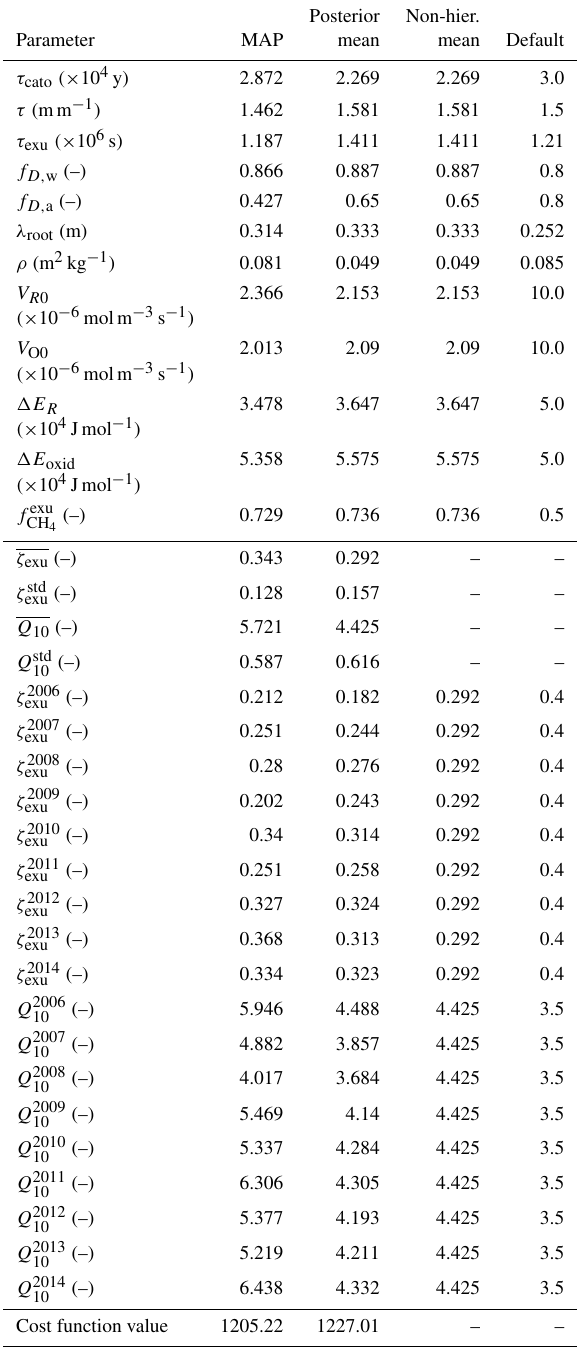
Table 4. Parameter values obtained in the optimization of the sqHIMMELI model with importance resampling. The maximum a posteriori, posterior mean, non-hierarchical mean (mean values used for hierarchically varying parameters), and values from Raivo- nen et al. (2017) are shown. The horizontal line in the middle sep- arates the hierarchically optimized parameters (including their pri- ors) from the others. Posterior Non-hier. Parameter